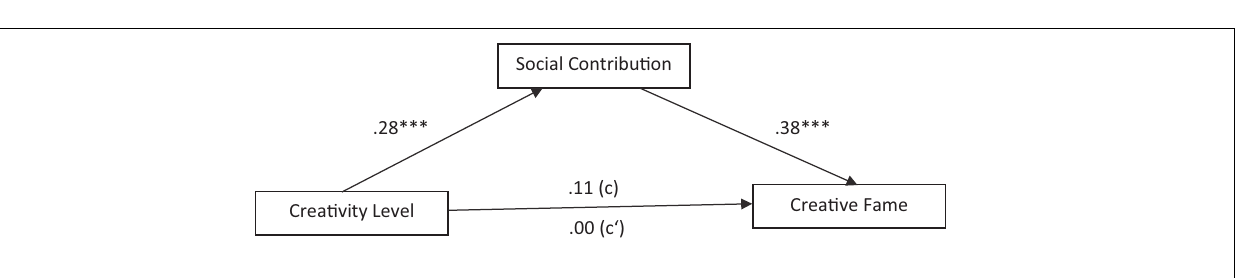
FIGURE 2 | Mediation model of social contribution between creativity level and creative fame: meritorious salience areas. ∗∗∗ p < 0.001.